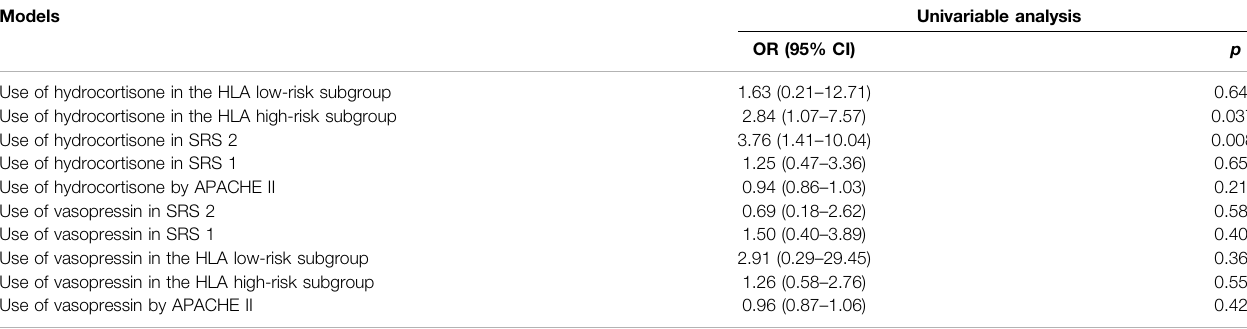
TABLE 3 | Comparisons of the predictive value of the HLA classi fi er versus disease severity and SRS.